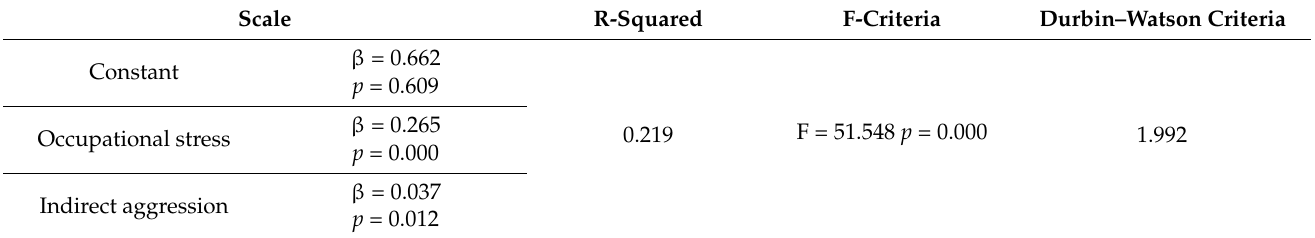
Table 8. Assessment of the contribution of occupational stress and indirect aggression to the develop- ment of depersonalization in non-COVID-19 ICU HCWs.